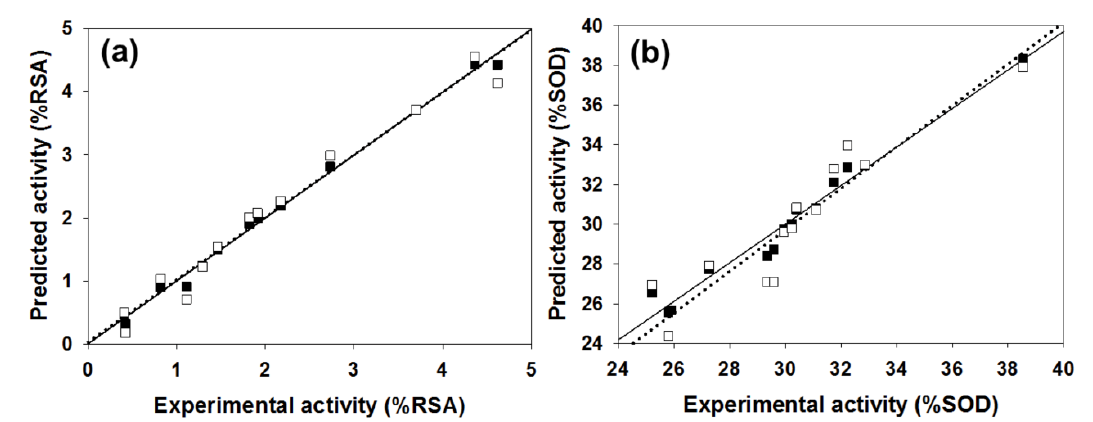
Figure 2: Plot of the experimental versus predicted RSA ( a ) and SOD ( b ) activities using MLR meth- od. The training set was represented by black squares and solid line, and the leave-one-out cross- validation set was assigned by white squares and dotted